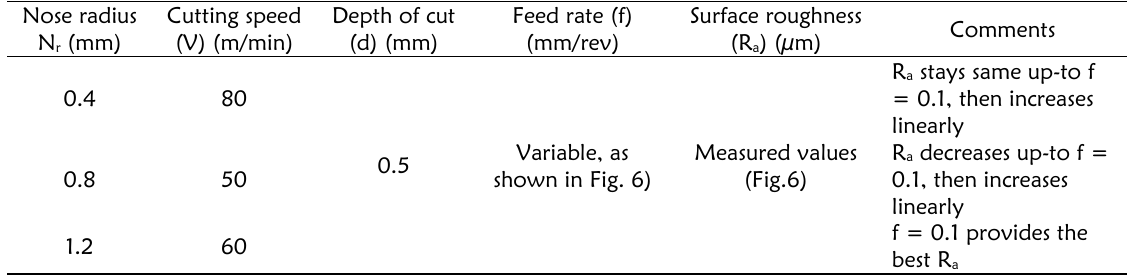
Table 2: Operational data for feed rate